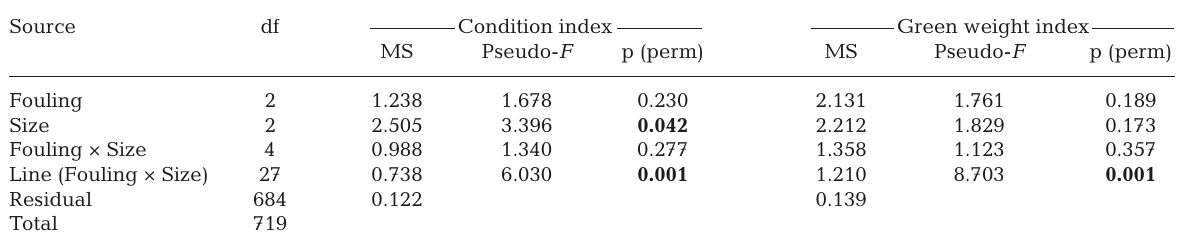
Table 4. Perna canaliculus . Permutational ANOVAs testing for mussel size class and fouling treatment effects on condition index and green weight index (see Fig. 7). Analyses based on Euclidean distances of the square-root-transformed data, and each term was tested using 999 random permutations of appropriate units. Significant values (p < 0.05) indicated in